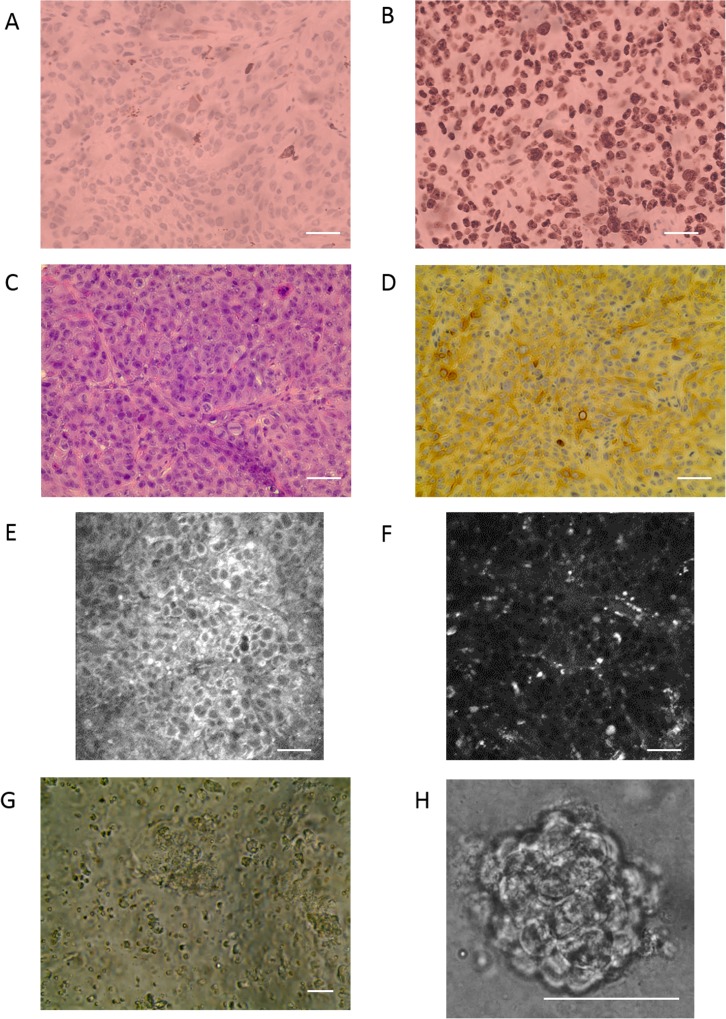
Representative immunohistochemistry, histology, and autofluorescence images of tumor tissue and brightfield microscopy for organoid generation.(A) Cleaved caspase-3 staining shows minimal apoptosis. (B) Ki-67 staining demonstrates high cell proliferation. (C) H&E staining indicates tissue composition of dense tumor cells. (D) Cytokeratin AE1/AE3 indicates positive staining of epithelial cells, which constitute the majority of the tumor. (E) NAD(P)H autofluorescence shows NAD(P)H located in the cell cytoplasm. (F) FAD autofluorescence shows punctate fluorescence signal from mitochondrial FAD. (G) Tissue was mechanically digested to create a suspension of cells. (H) Cells grow as organoids after plating the cell suspension. Scale bar = 50um.